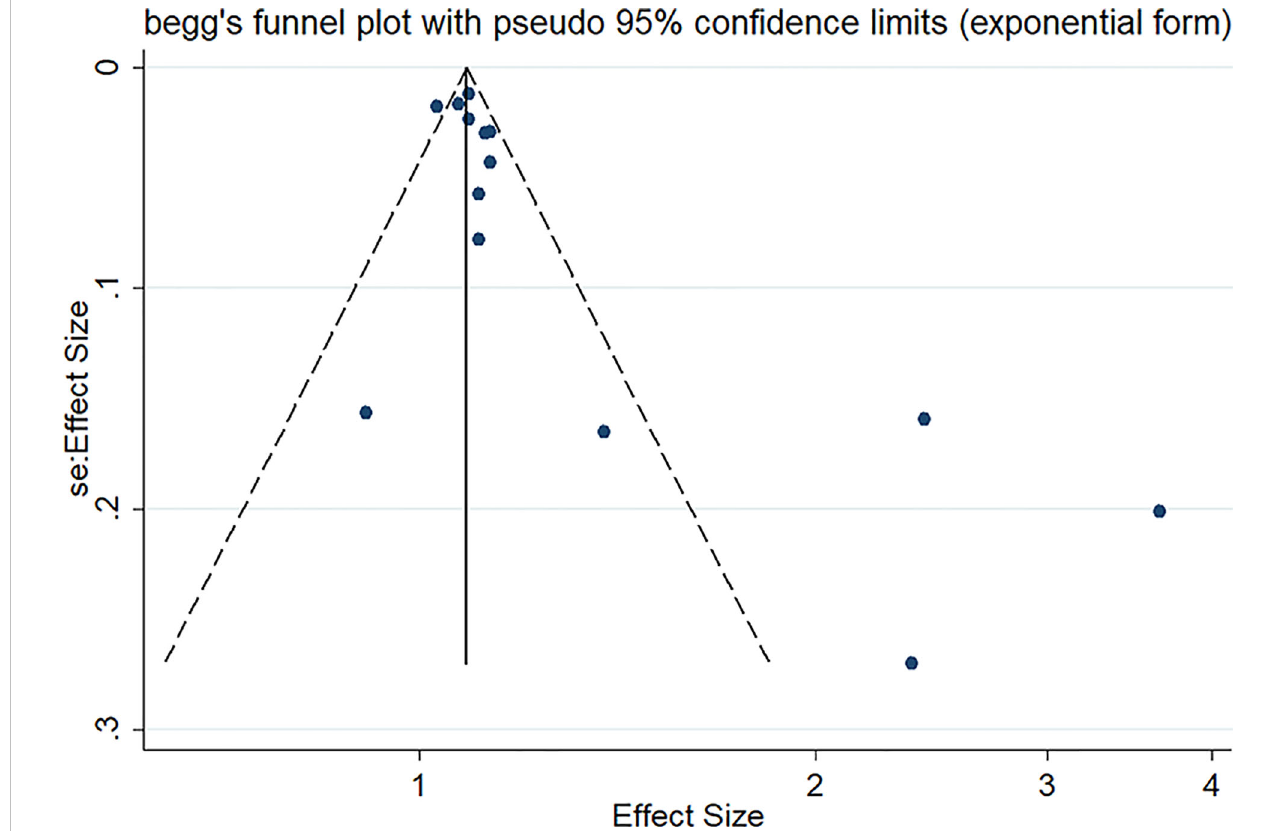
FIGURE 3 Funnel plot for the effect estimates of TyG index.